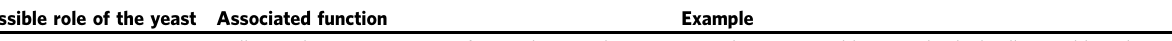
Table 1 Multiple roles yeast can play in SCRaMbLE experiments Possible role of the yeast Associated